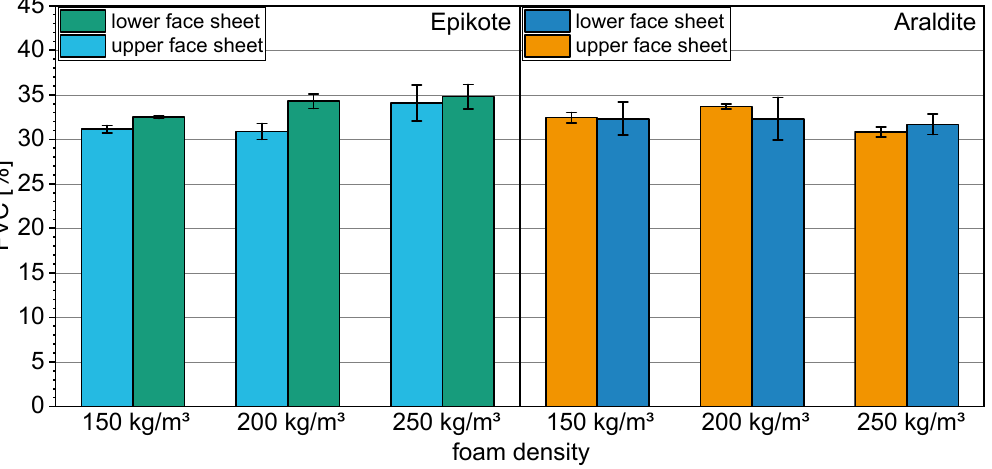
Figure 5. Fiber volume contents of the lower and upper face sheets according to the foam core density for the Epikote (left) and the Araldite resin systems (right).